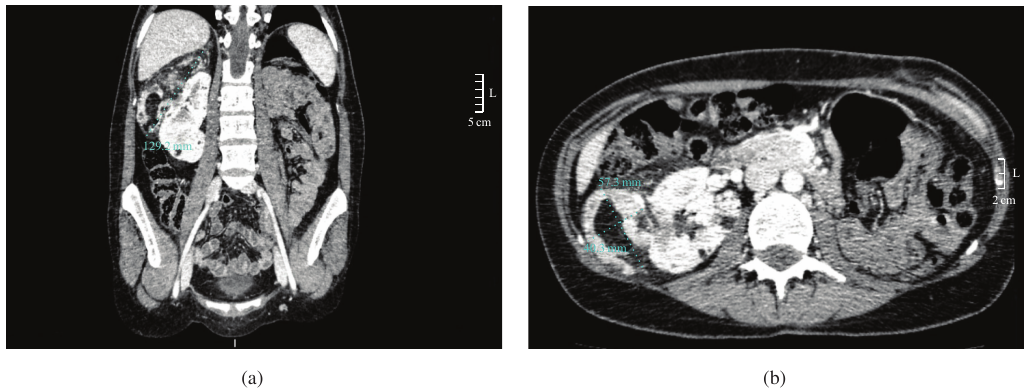
FIGURE 1: (a) Coronal CT revealing a well-circumscribed heterogenic mass lateral to the right kidney with appearance of a giant angiomyolipoma measuring 129 . 2 × 51 . 5 mm. (b) Axial CT appearance of the right renal angiomyolipoma measuring 57 . 3 × 40 . 3 mm. Small intraparenchymatous cystic lesions were